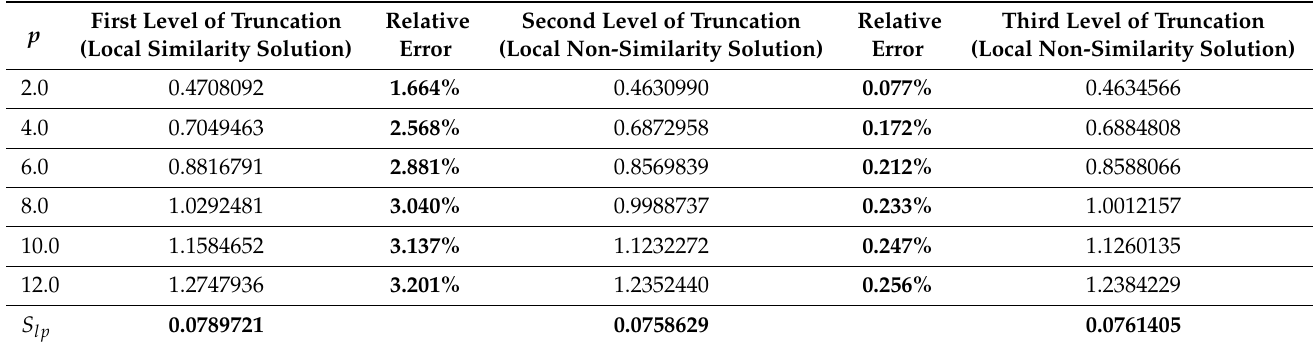
Table 4. Skin friction Coefficient index parameter ( p ) from different levels of truncation, assuming that ξ = −